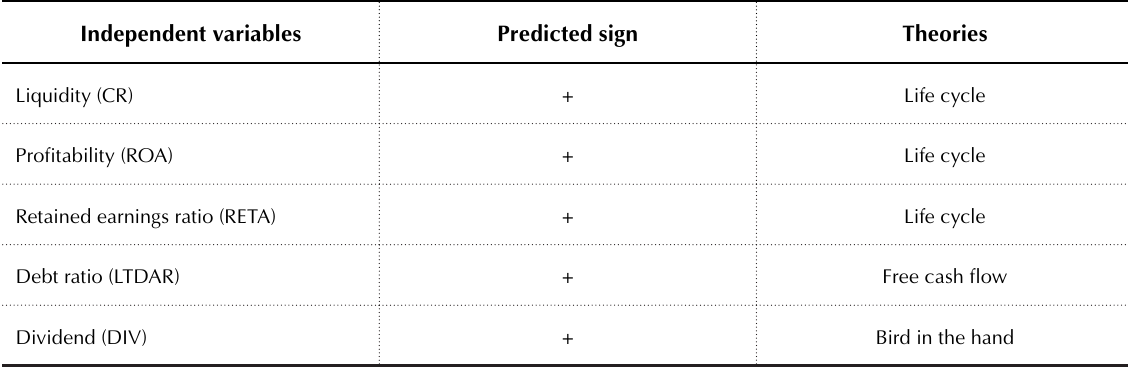
Table 1. Summary of hypotheses development for testing the relationship of market reaction and fundamental